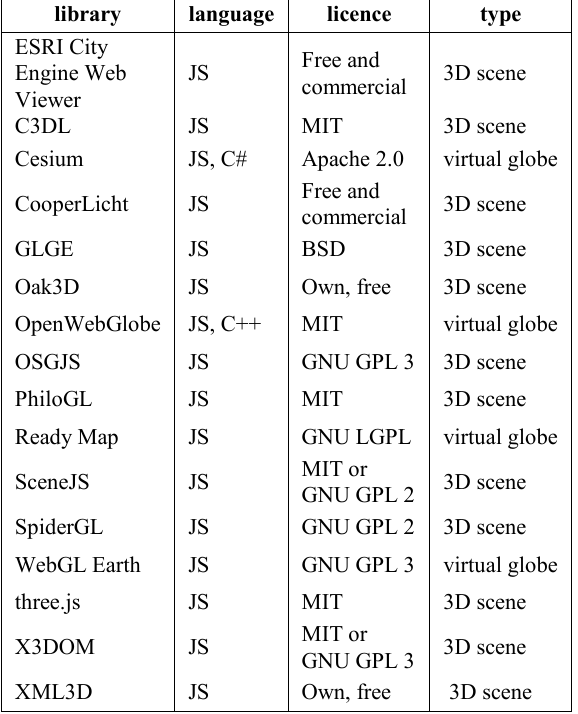
displaying the overview map.